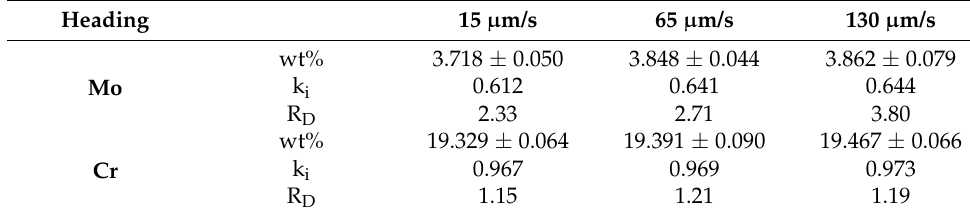
Table 3. Elemental solute partition coefficients during